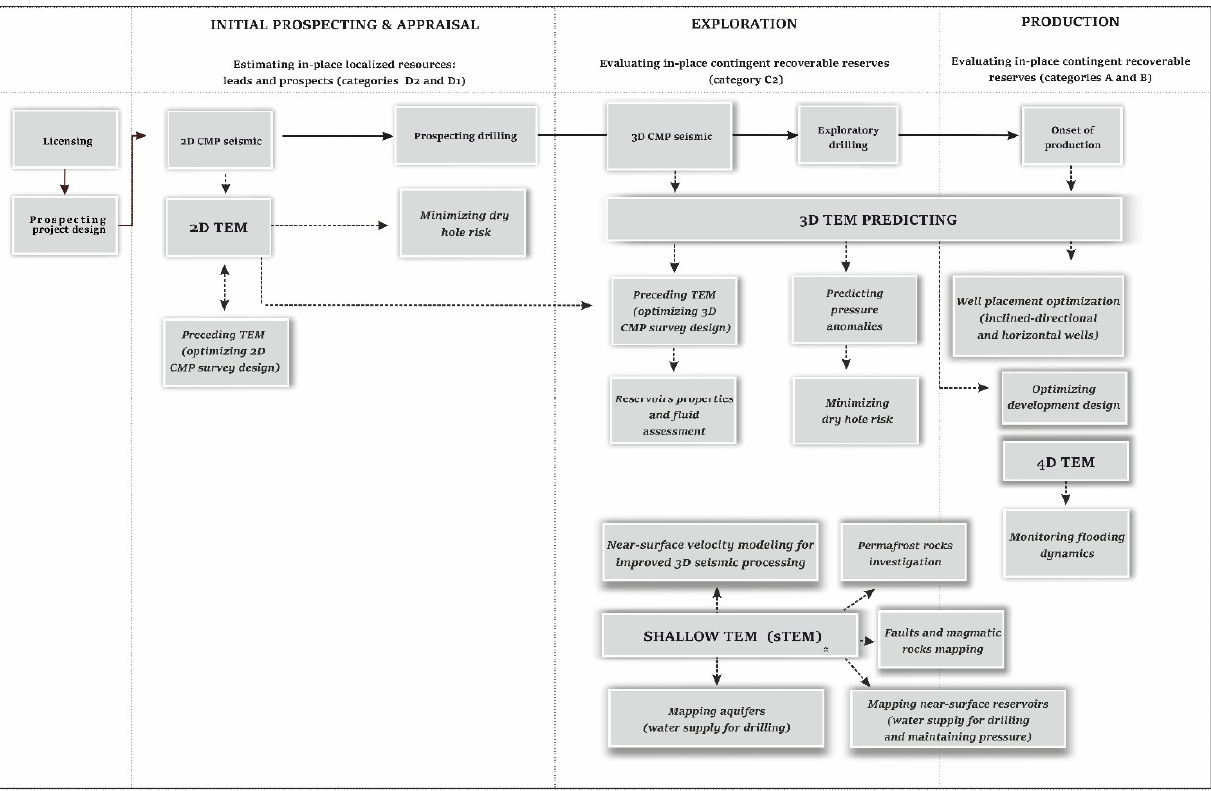
Figure 3. Workflow of seismic and TEM surveys, modified after [31].